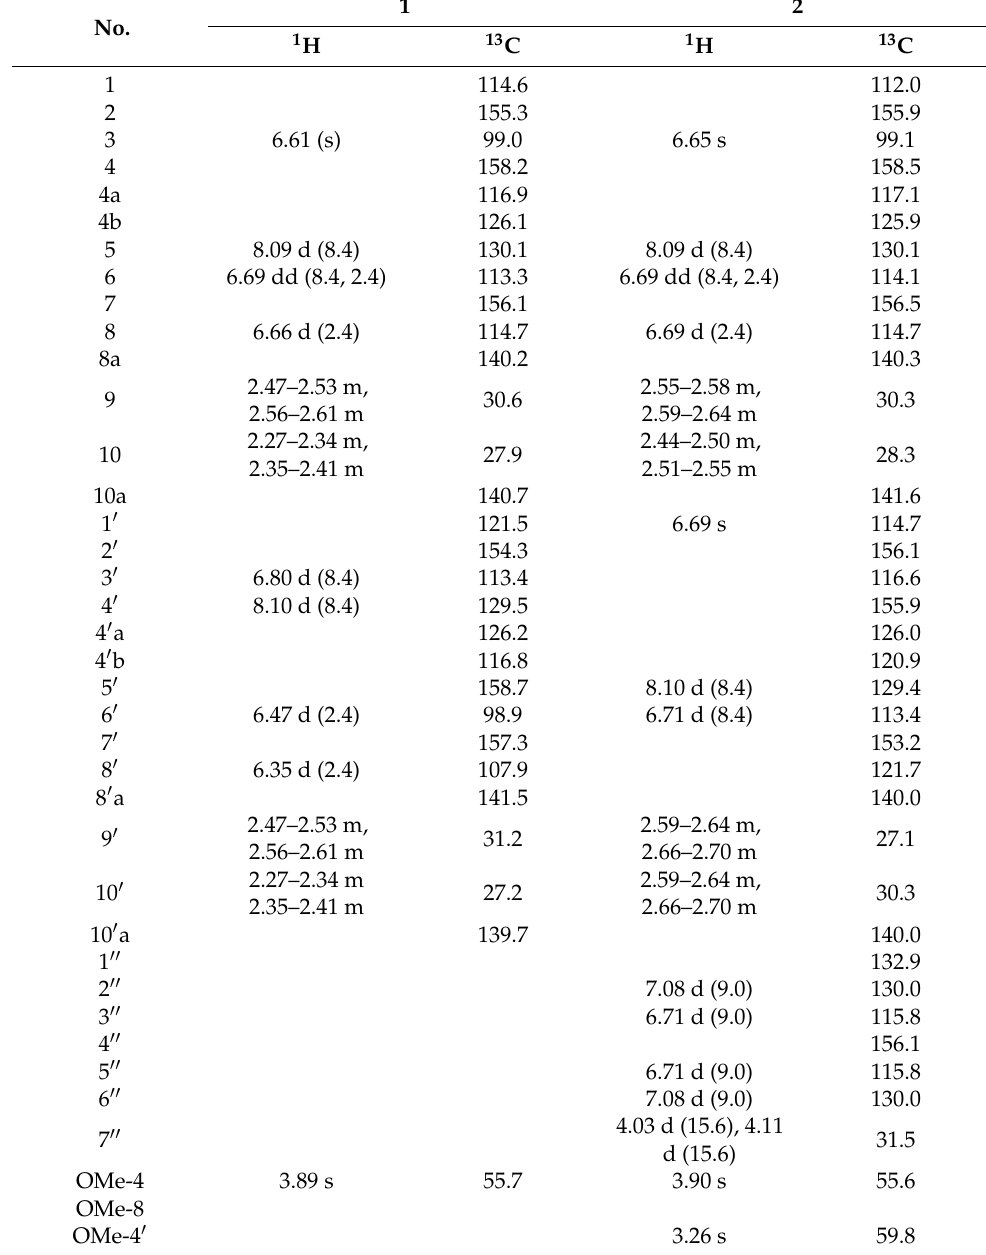
Table 1. 1 H- (600 MHz) and 13 C- (150 MHz) NMR data of compounds 1 and 2 ( δ in ppm, J in Hz). NMR data were measured in acetone- d